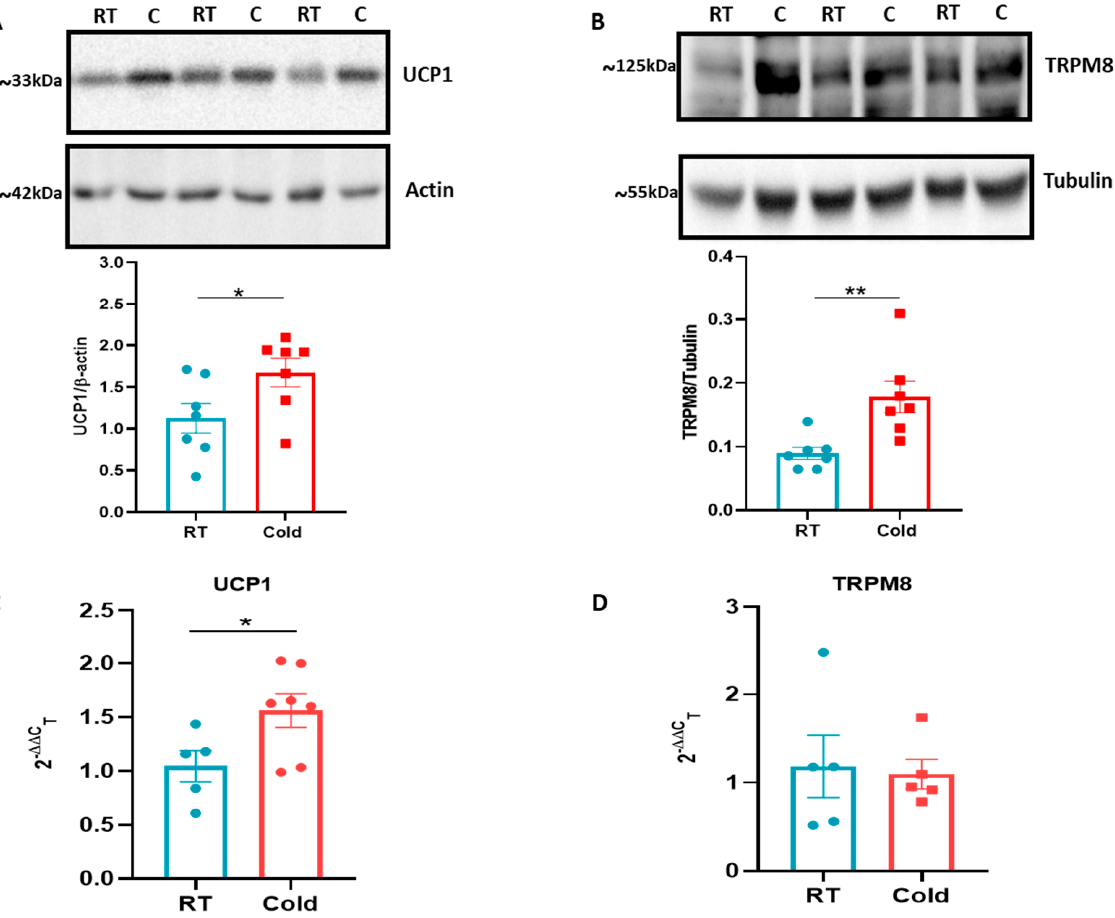
are for n = 6 mice. ( G – L ) Graphs for C57BL/6 mice represents ( G ) the mean core body temperature and ( H ) the mean activity changes in mice during 3 h cold (4 ◦ C) exposure in a climatic chamber or RT treatment ( n = 6). ( I ) the initial temperature increase at the start of cold exposure in the climatic chamber or RT treatment; ( J ) the minimum temperature that was achieved during 3 h of RT/cold exposure; ( K ) The area under the curve (AUC) analysis of temperature during 3 h of RT/cold treatment. ( L ) The area under the curve (AUC) analysis of activity during 3 h of RT/cold treatment. The results are for n = 6 mice. All the data are presented as the mean and the error bars indicate standard error of mean (S.E.M). * p < 0.05, ** p < 0.01; Two-tailed Student’s t -test.